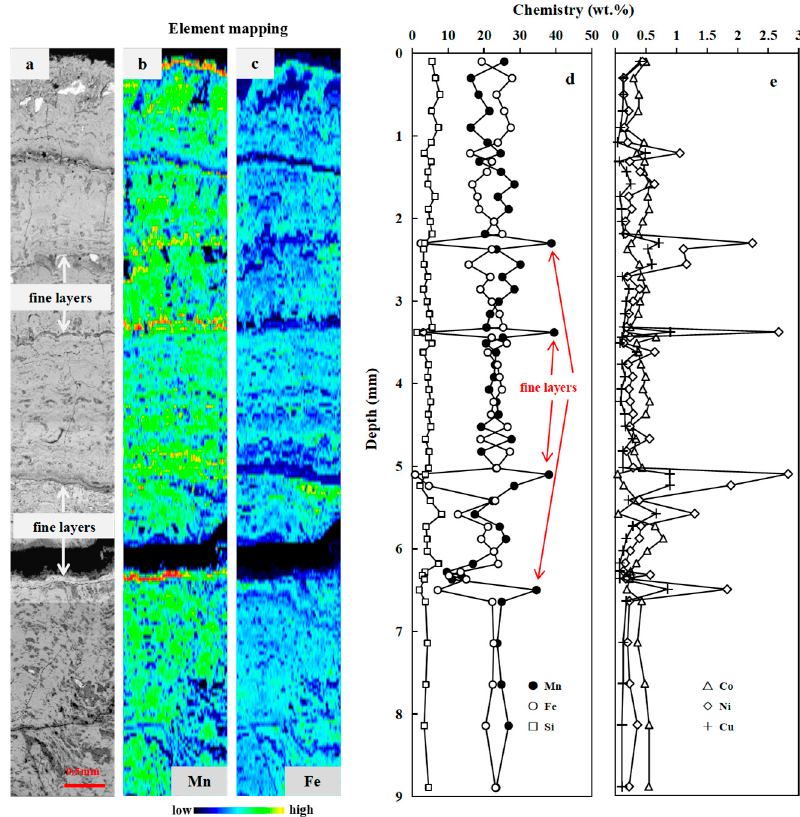
Figure 3. Microscopic investigations and depth profiles of element contents of FND-49. ( a ): BSE image; ( b , c ): X-ray Mn and Fe intensity maps; ( d , e ): Depth profiles of Mn, Fe, Si, Ni, Cu, and Co content. (Microscopic investigations and depth profiles of element contents of D07 are available in the Supporting Information.).